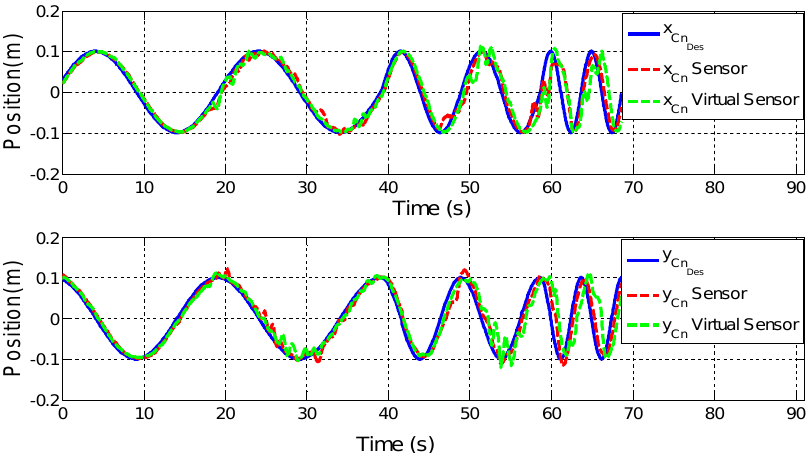
Figure 7. Validation of the Motion Virtual Sensor in ARM operating mode.